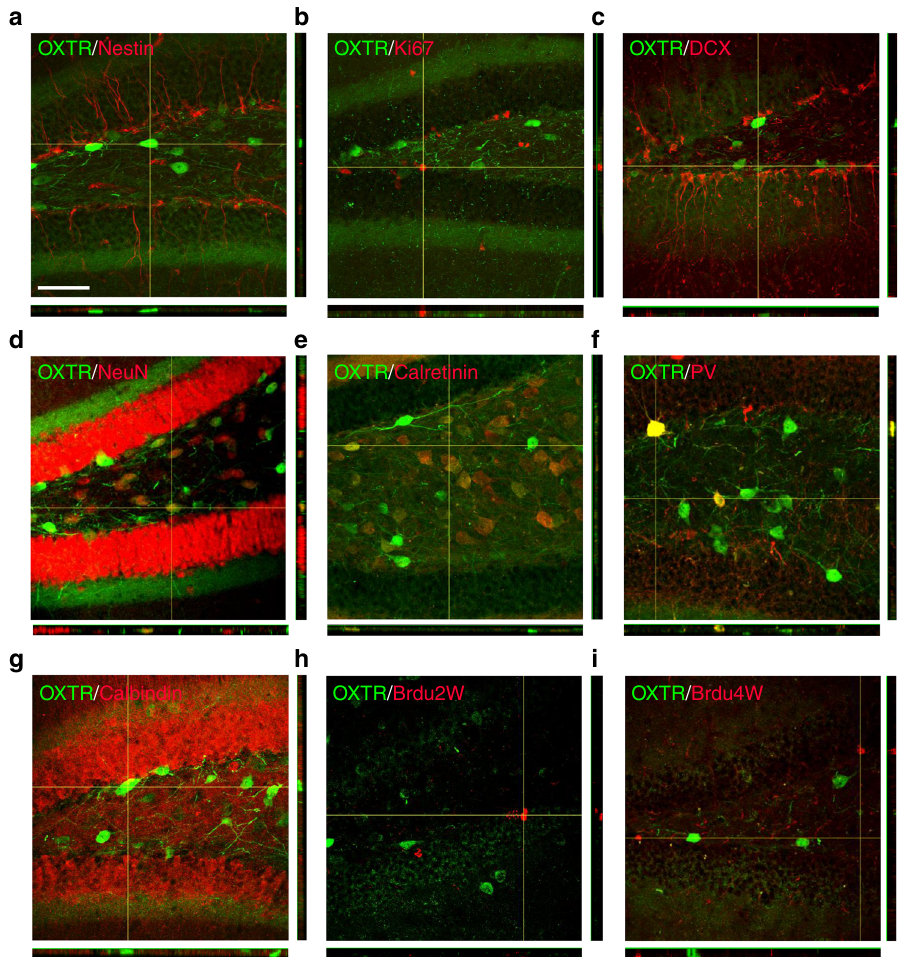
Fig. 1 Expression of OXTR in the DG. a – g Double-labeled confocal immuno fl uorescence images showing the colocalization of OXTR ( green ) expression with a nestin ( red ), b Ki67 ( red ), c DCX ( red ), d NeuN ( red ), e calretinin ( red ), f parvalbumin ( PV , red ), and g calbindin ( red ) in the DG of 10-week-old Oxtr Venus- Neo/+ mice. h , i Immuno fl uorescent staining of BrdU. Oxtr Venus-Neo/+ mice were injected with BrdU and killed 2 or 4 weeks later. Representative images of BrdU + cells at h 2 week and i 4 weeks. Data was replicated in four mice. Scale bar , 50 μ